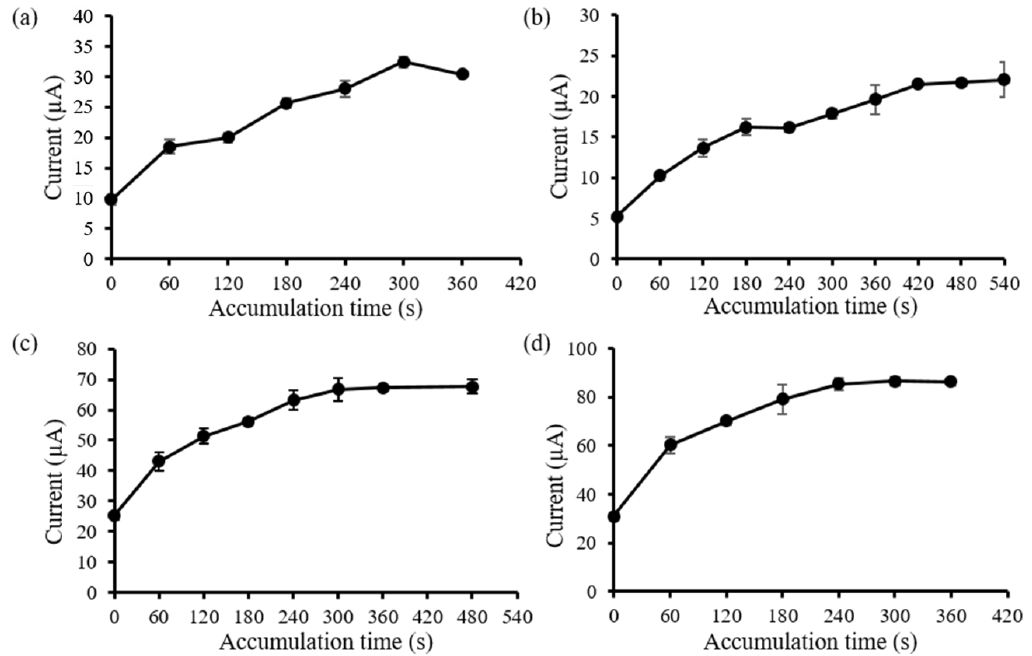
Figure 6. Oxidative current response of 50 µM of amaranth ( a ), tartrazine ( b ), sunset yellow ( c ), and carminic acid ( d ) at different accumulation time .